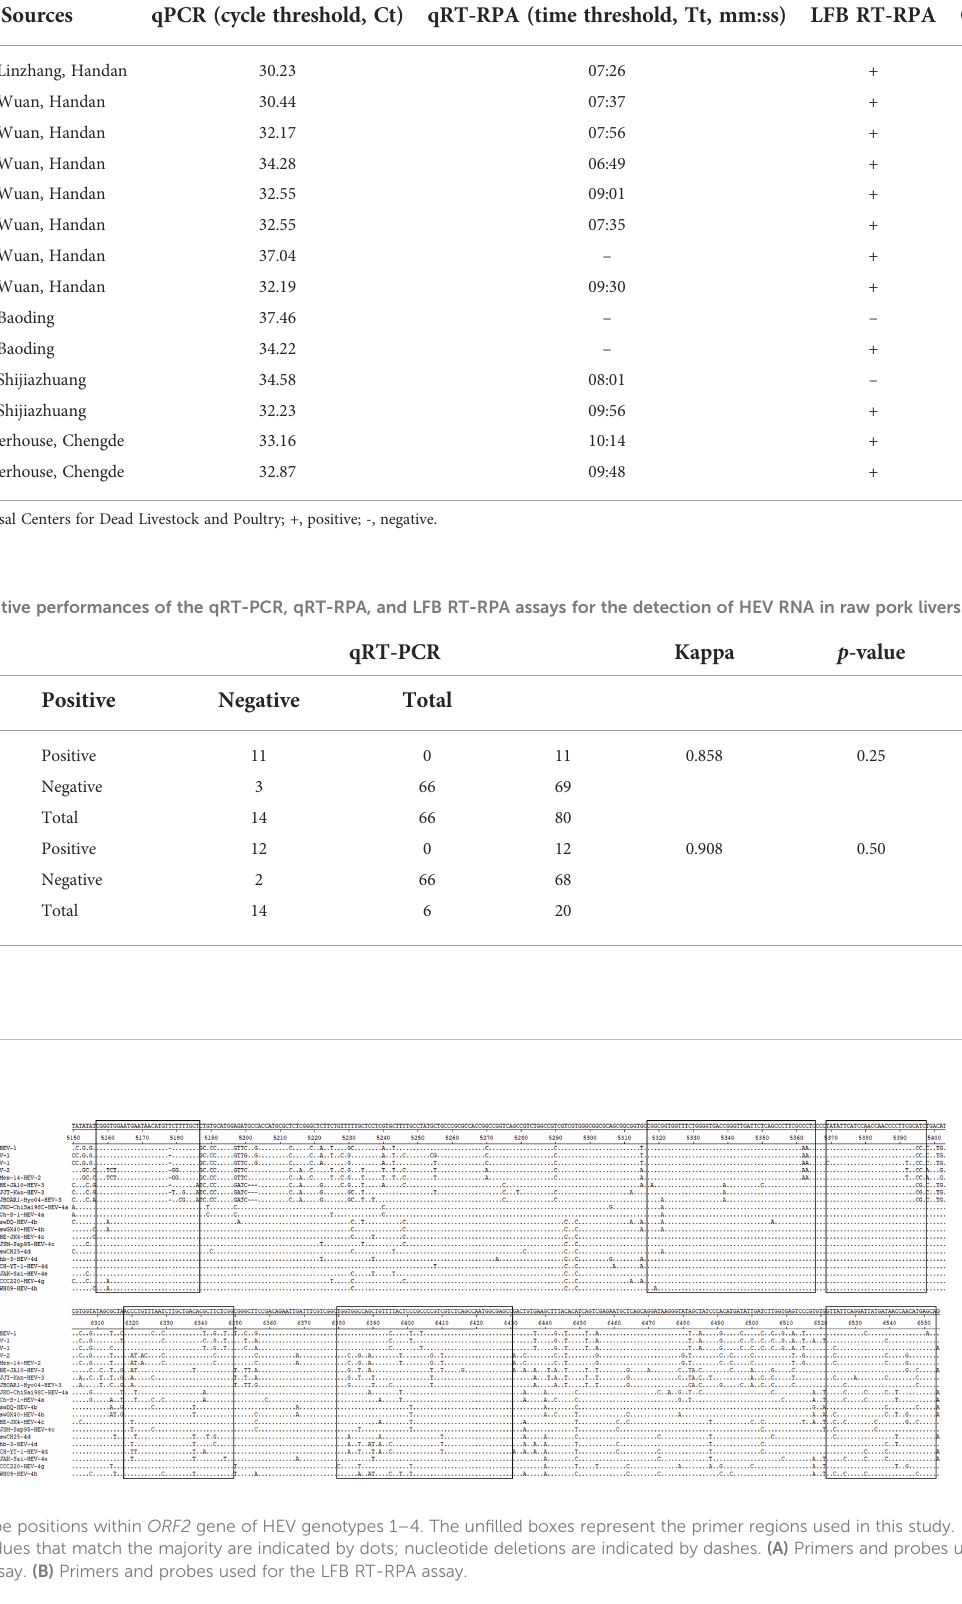
TABLE 2 Detection results of the HEV RNA-positive